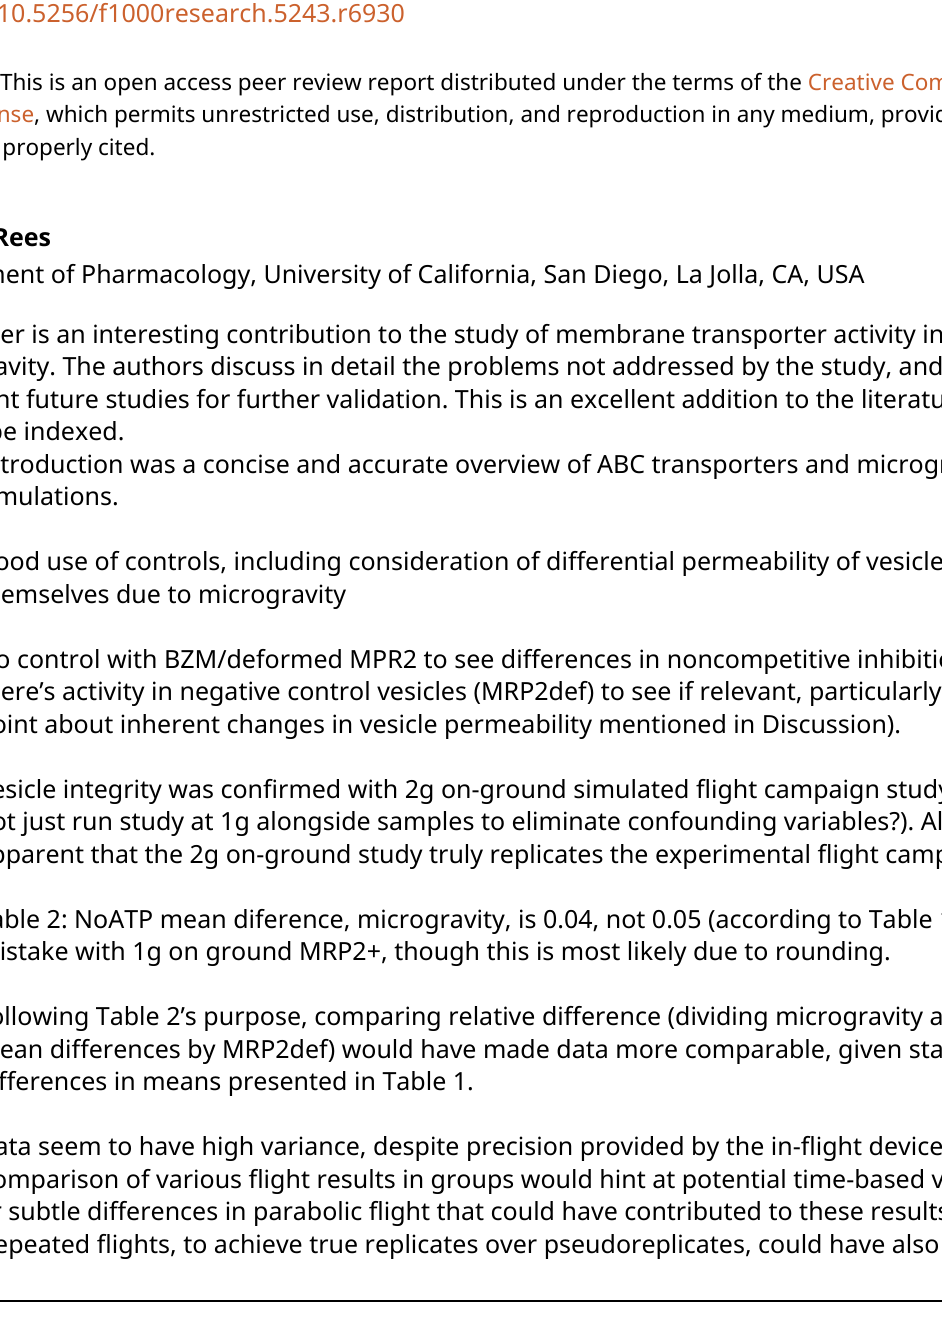
Table 2: NoATP mean diference, microgravity, is 0.04, not 0.05 (according to Table 1). Same mistake with 1g on ground MRP2+, though this is most likely due to